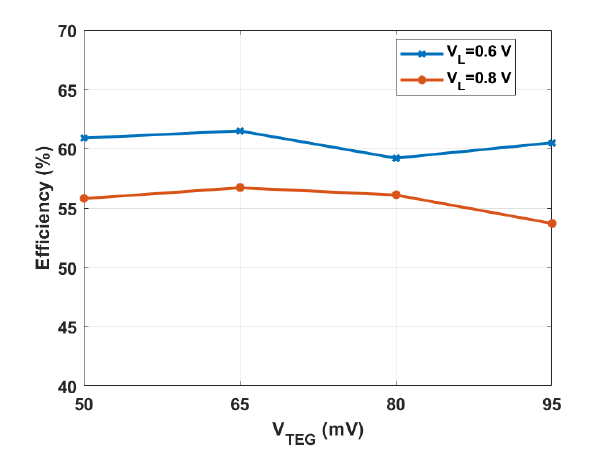
Figure 11. Power efficiency versus V TEG of SI boost regulator at I L = 10 µ A.